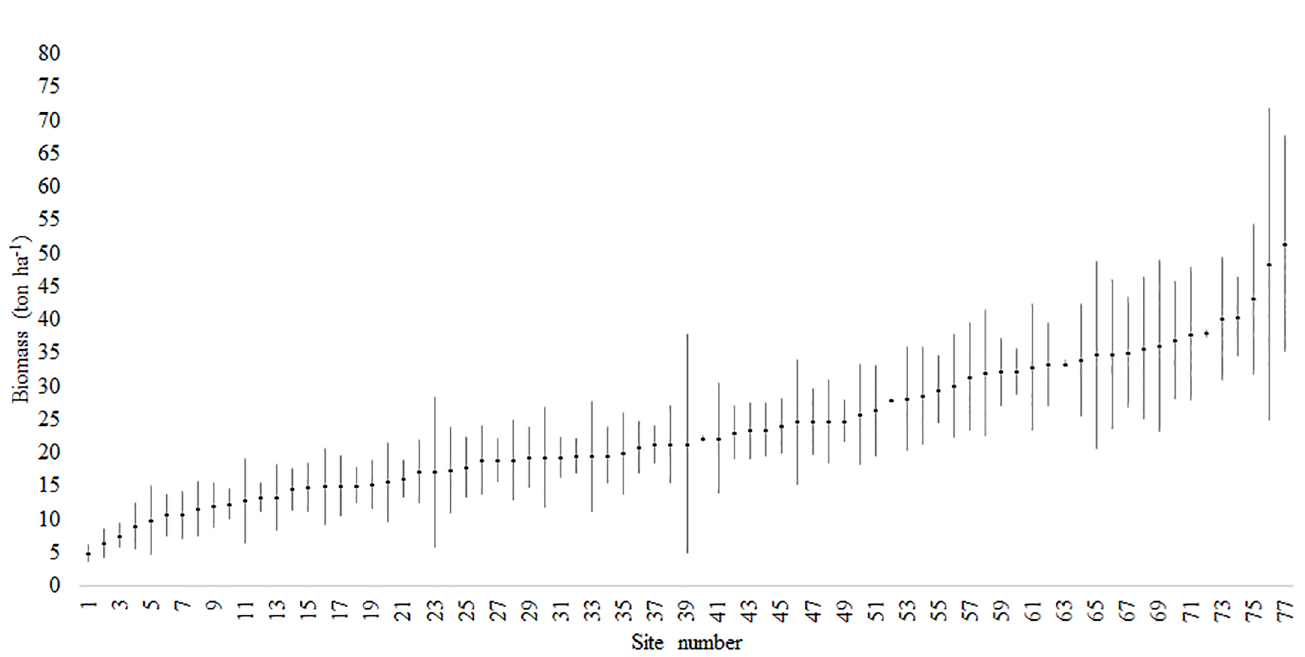
Fig 4. Tree aboveground biomass density and confidence interval of 77 cerrado sensustricto sites, estimated with model 11.